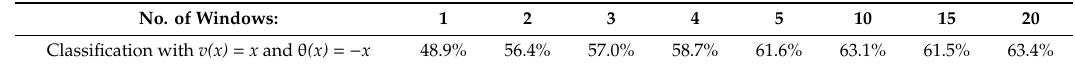
Table 2. Optimal empirical estimation of the number N of windows.